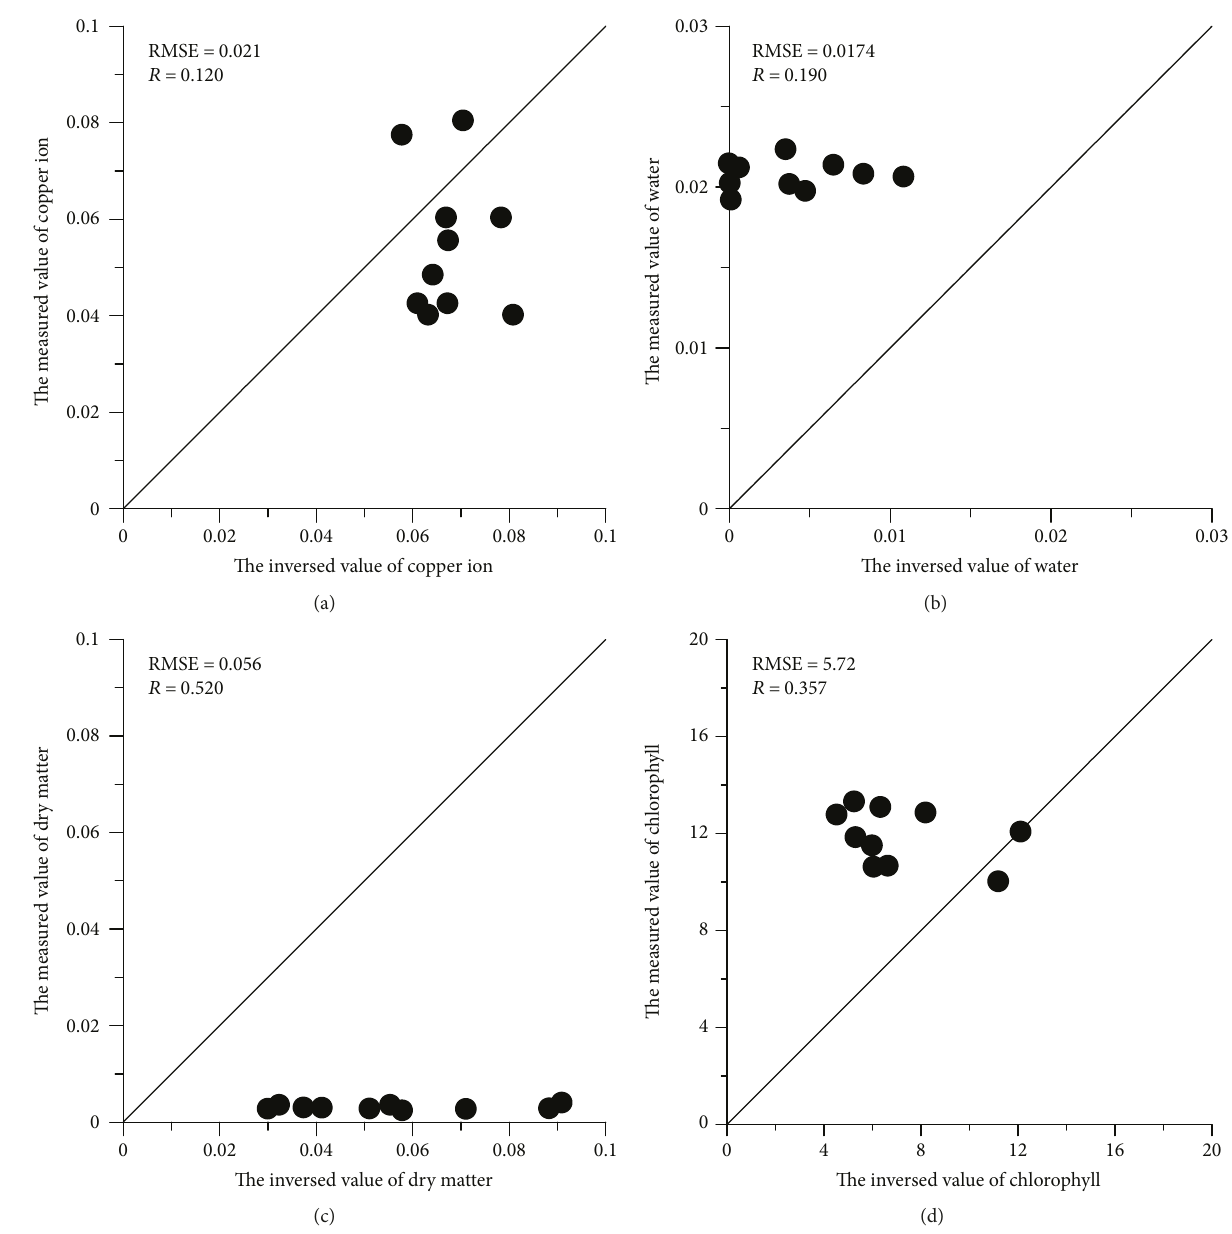
Figure 3: Comparison between the inverted and measured biochemical components of leaves: (a) copper ion content, (b) water content, (c) dry matter content, and (d) chlorophyll